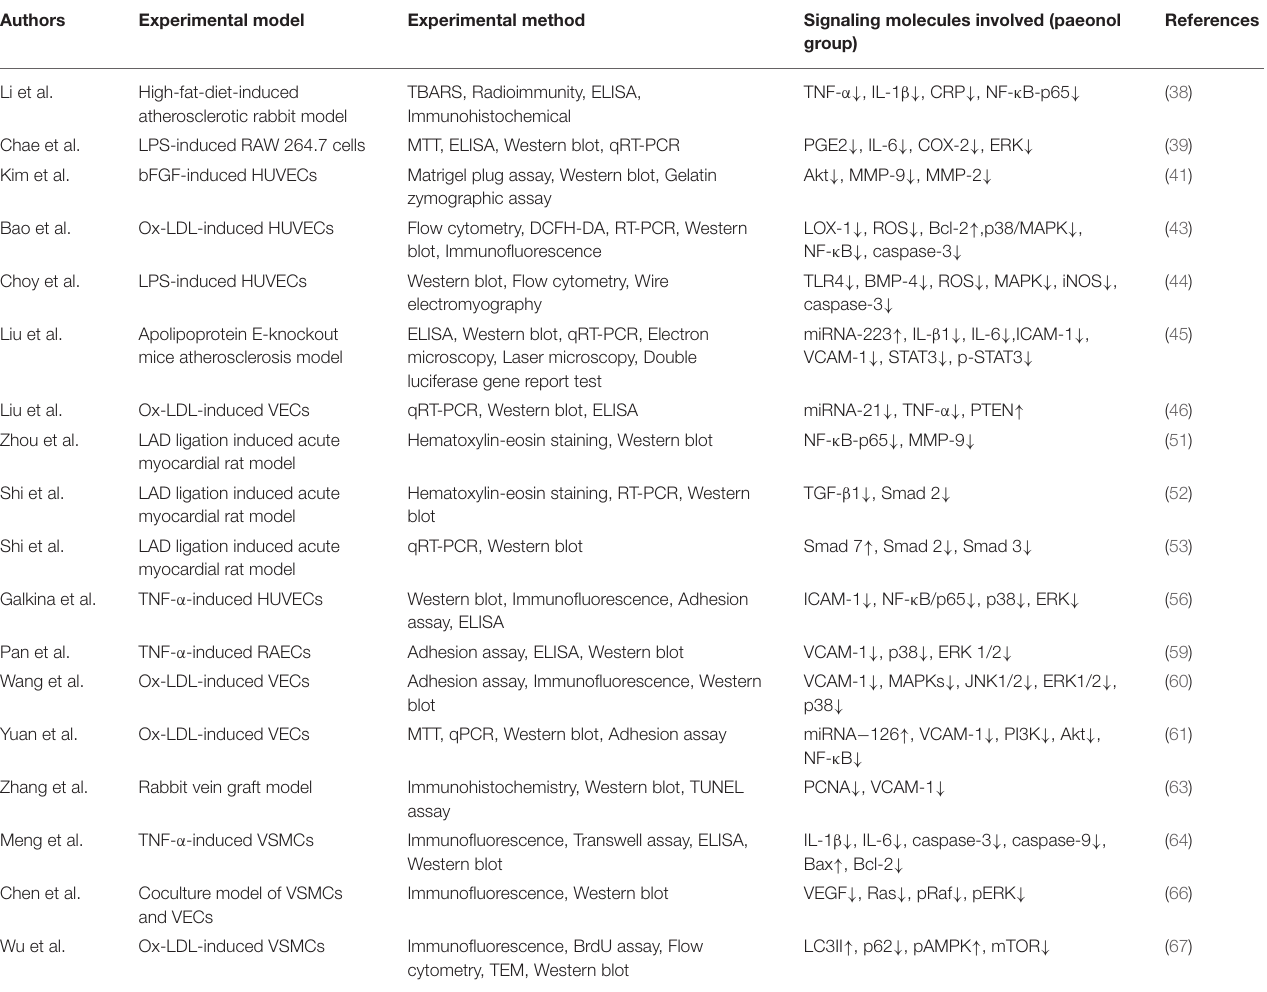
TABLE 1 | Experiments on the anti-inflammatory mechanism of paeonol in atherosclerotic cardiovascular